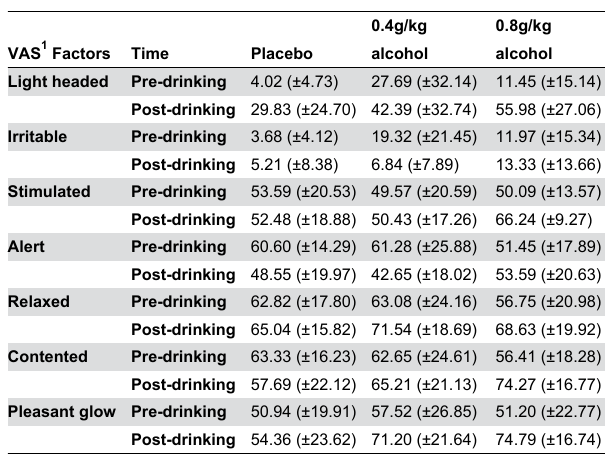
Table 2. Subjective ratings of feelings due to alcohol ingestion (VAS) taken pre- and post-drinking, presented separately for the placebo, the 0.4g/kg, and the 0.8g/kg alcohol-dose